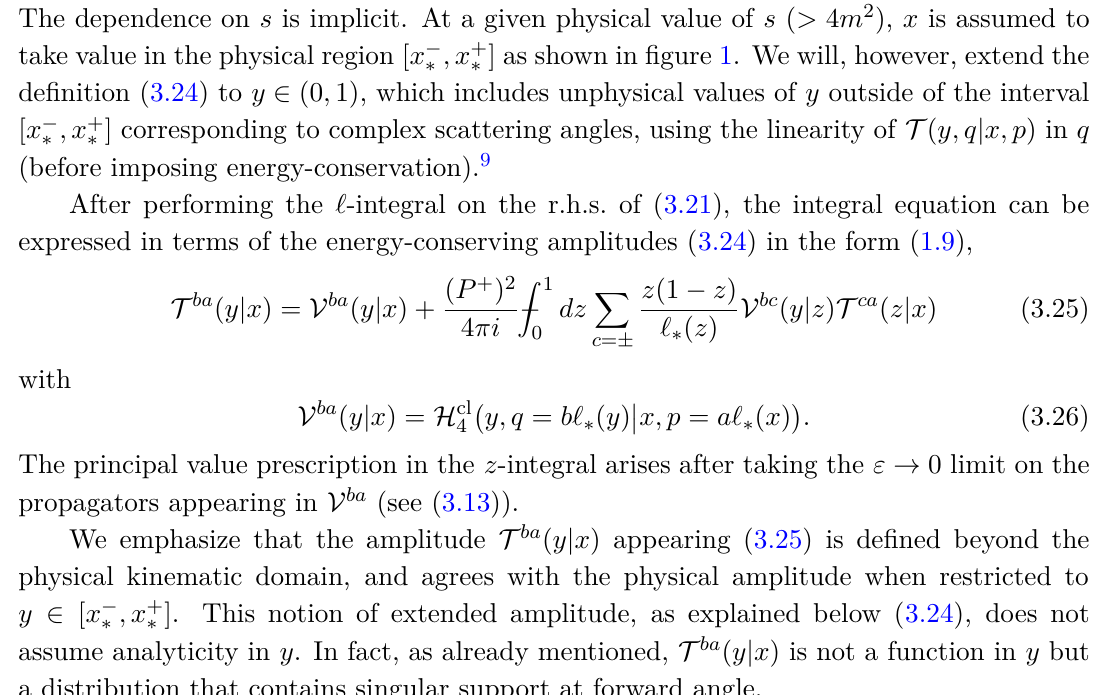
Figure 3 . Left panel: path of ‘ ∗ ( z ) in the complex ‘ -plane as z varies from 0 to 1. Right panel: path of the intermediate state’s angle γ as z ranges from 1 to z − then